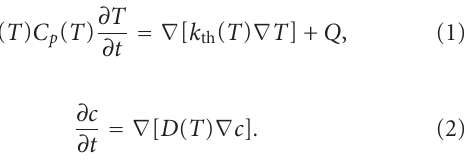
laser parameters on the emitter formation, the finite